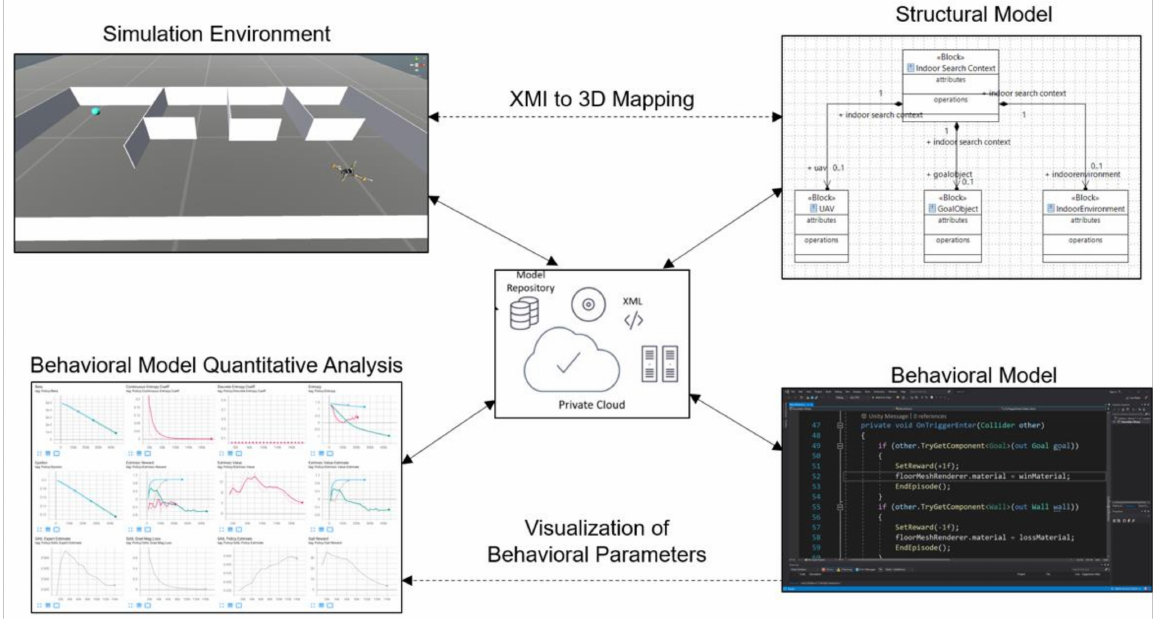
Figure 16. Quantitative analysis setup using testbed.